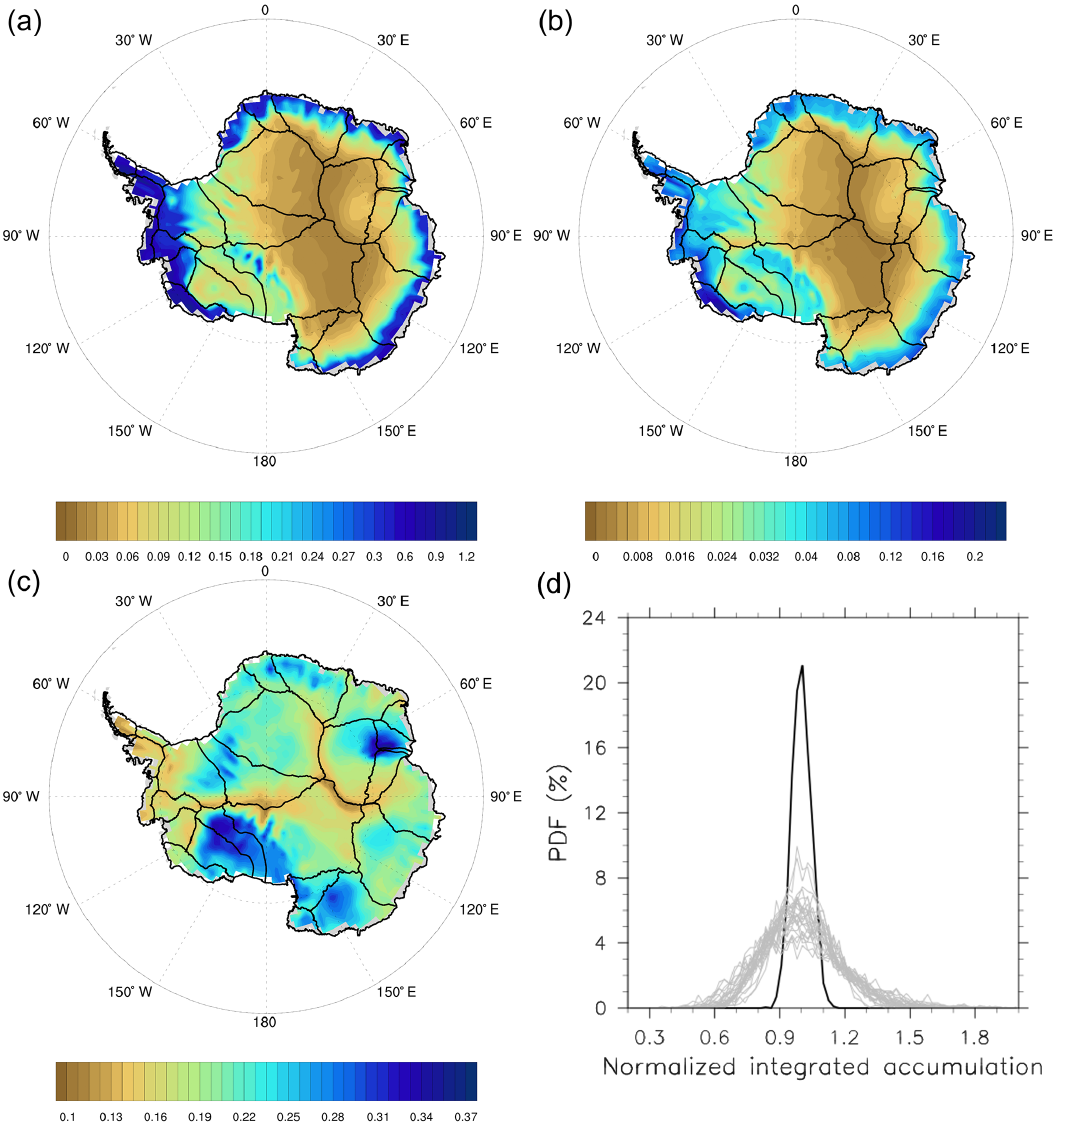
Figure 2. (a) Climatological mean CESM-simulated AIS precipitation (myr − 1 w.e.). (b) Climatological AIS standard variability (standard deviation,myr − 1 w.e.). (c) Coefficient of variation (CV, standard deviation divided by the mean). AIS drainage basins (Zwally et al., 2012) overlaid on panels (a) – (c) . Note nonlinear color bars in panels (a) – (b) . (d) Normalized distributions of annual average precipitation, over the entire 1800-year simulation. Normalization carried out by dividing each distribution by the mean distribution value. Black line: AIS-wide integrated precipitation distribution. Grey lines: individual drainage basin